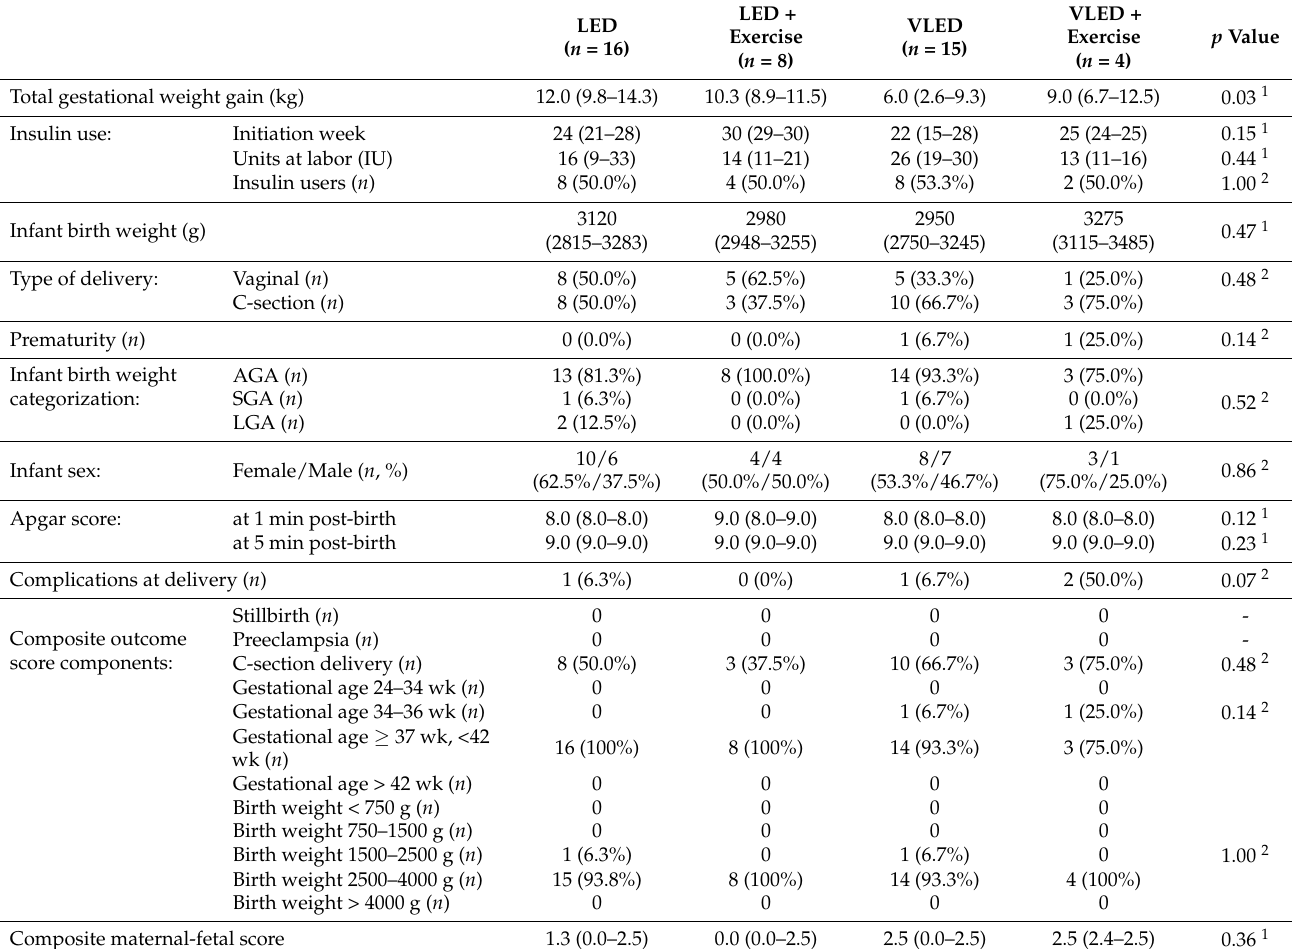
Table 2. Maternal, obstetrical and infant outcomes between intervention groups (presented as median and IQR or n , %).